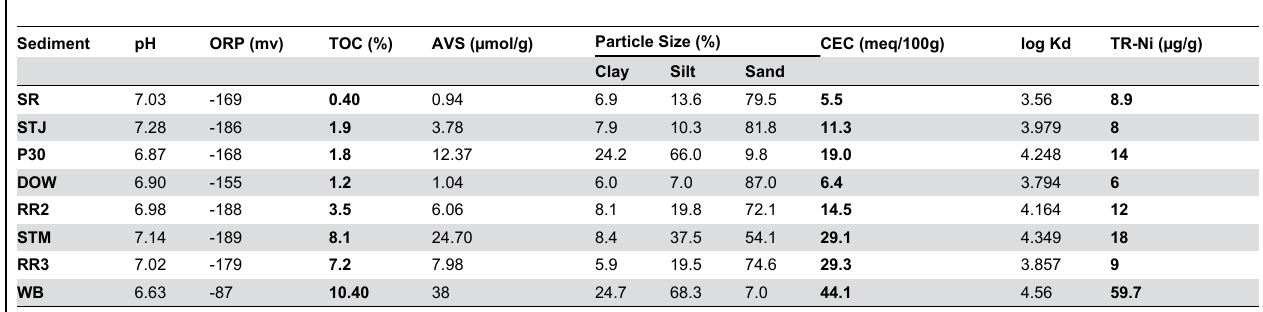
Nickel distribution coefficient, Kd = TR-Ni/pore-water Ni Table modified from Besser et al. 2011.